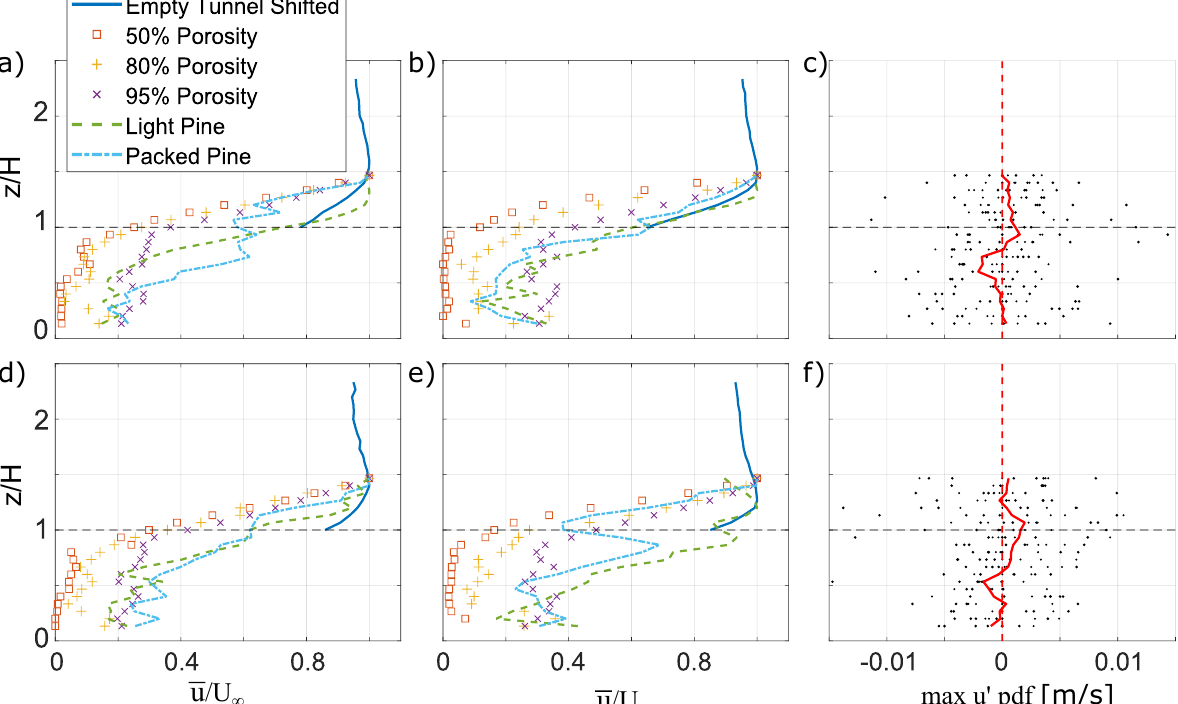
Figure 3. Mean streamwise velocity measured within the test section of the wind tunnel at ( a ) 17.5 and ( b ) 31 cm from the leftmost position (see in Figure 2a). The mean wind profile in the empty wind tunnel (solid blue line) is shifted upward by the thickness of the fuel models (0.075 m). ( c ) Streamwise velocity fluctuations ( u (cid:48) ) corresponding to the maximum probability density function (PDF) of u (cid:48) at each height from all measurements within the fuel layer (black dots); the red line indicates the mean values of the PDF of u (cid:48) at each height. The background maximum velocity in the empty wind tunnel is U ∞ = 2.2 m/s. ( d – f ) are the same as in ( a – c ) but for U ∞ = 1.5